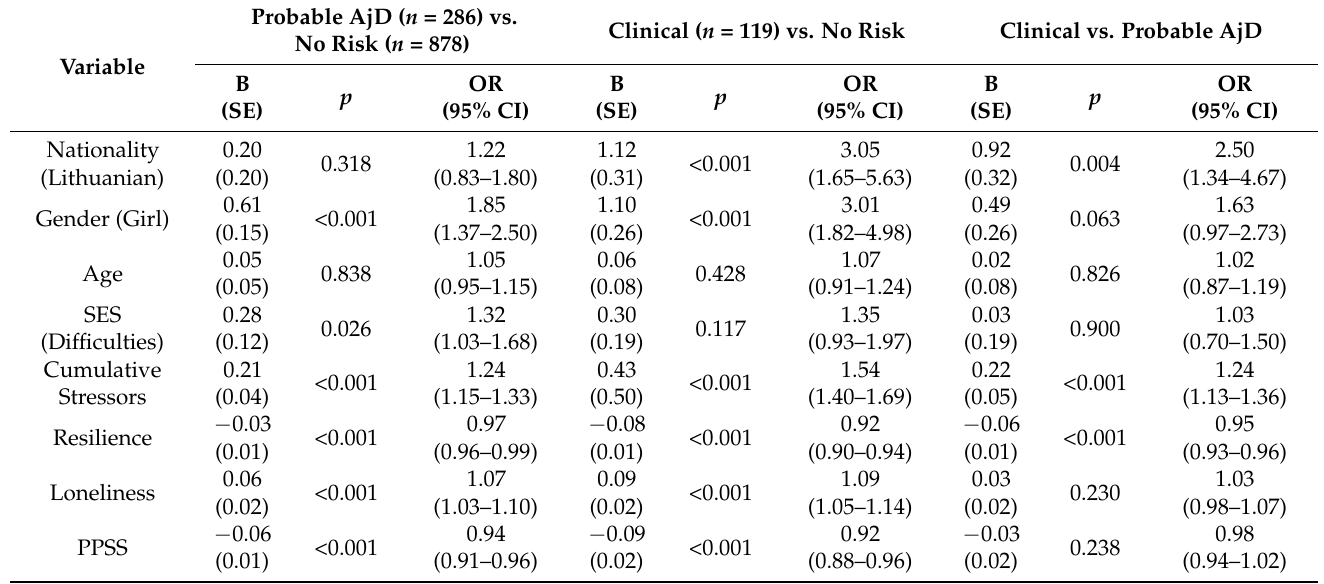
Table 4. Multinomial logistic regression for AjD prediction ( n =